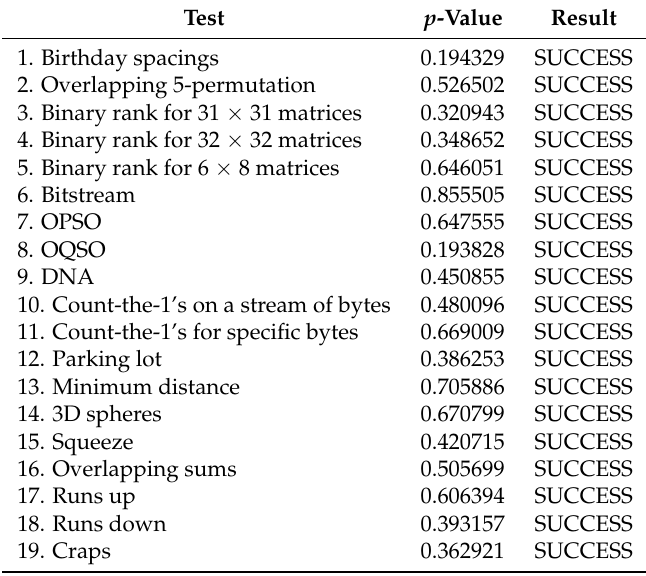
Table 6. p -values returned by DIEHARD tests when evaluating a sequence of 1.024 × 10 9 bits generated by